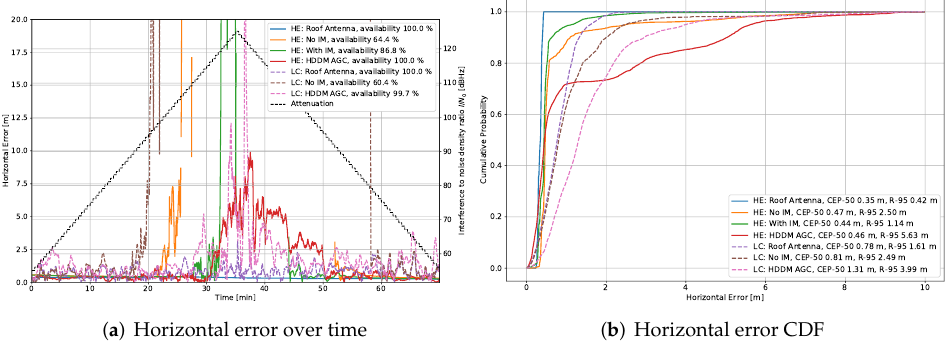
Figure A27. Interference #9: Filtered pulsed noise with 35MHz bandwidth, 50% duty cycle, and 100us pulse